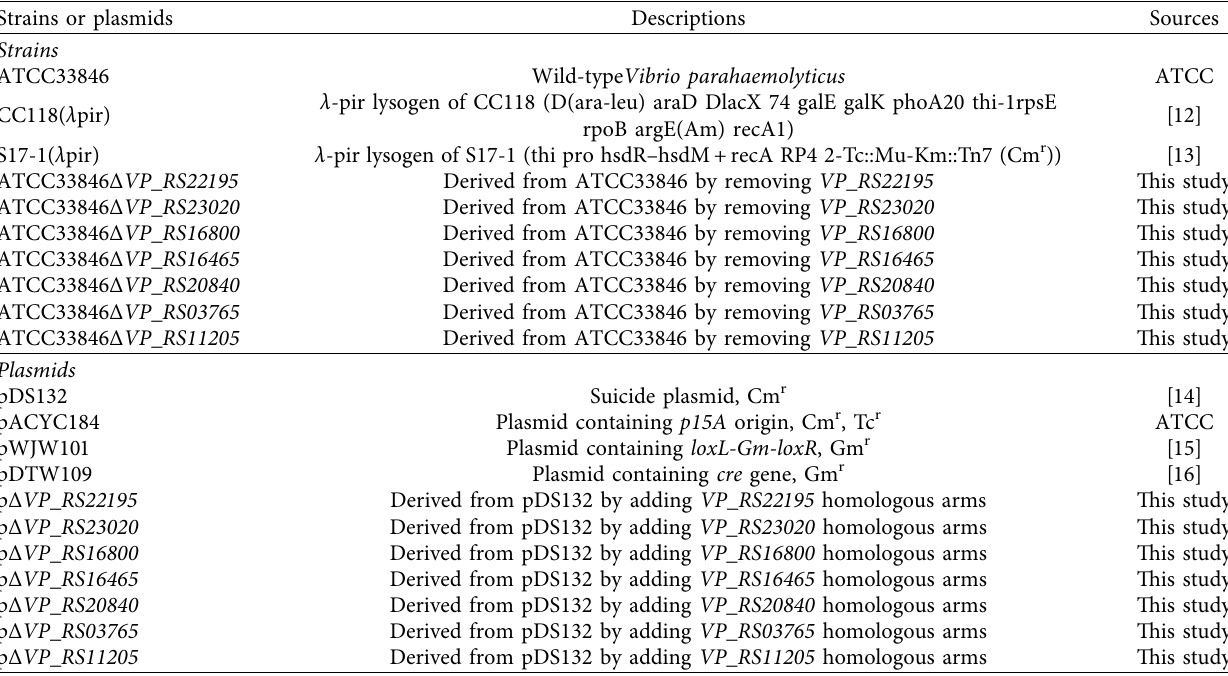
Table 1: Bacteria and plasmids are used in this study.